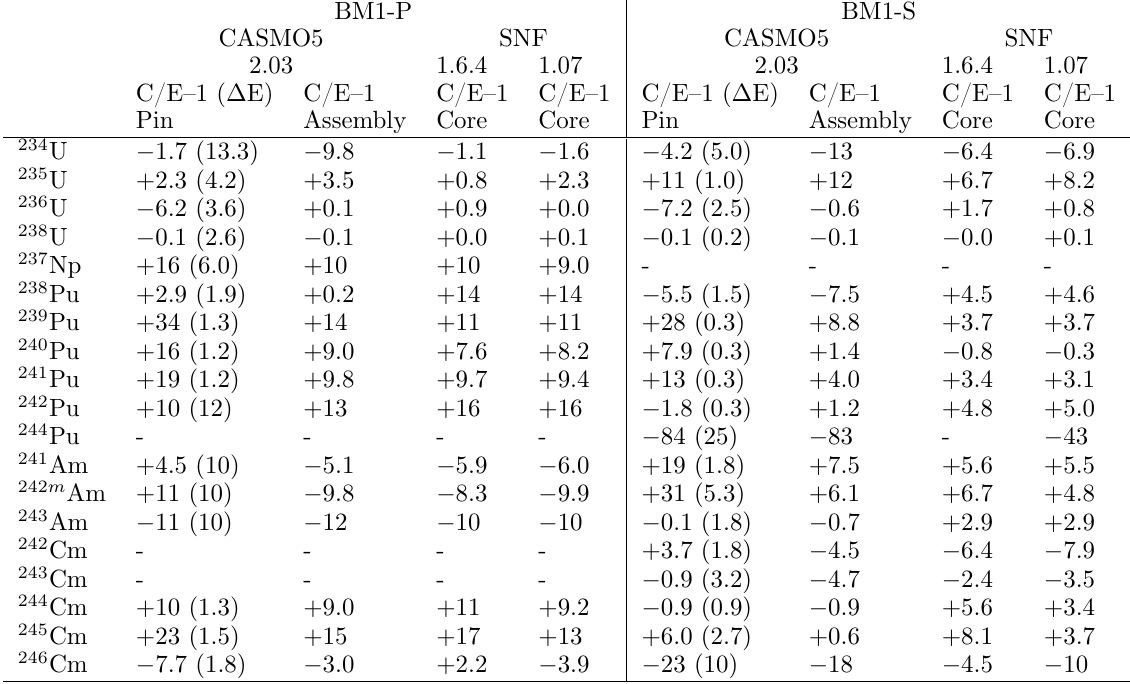
Table B.3. Nominal C/E–1 values and experimental uncertainties for actinides in % (1 σ ) for the BM1-P and BM1-S